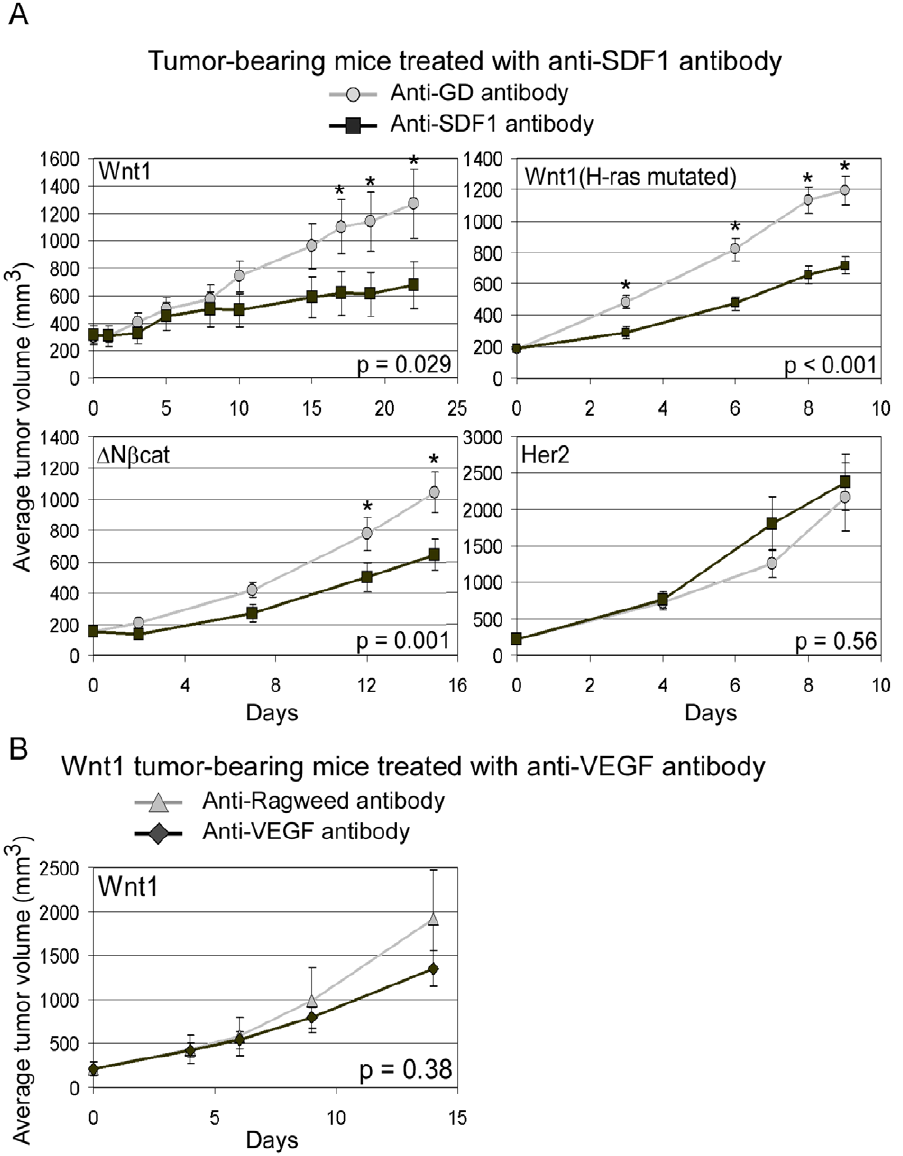
Figure 4. MMTV tumor-bearing mice treated with anti-SDF1 and anti-VEGF antibodies. Dissociated MMTV tumor cells were injected into nude mice, and tumor-bearing mice were injected with anti-SDF1 (circle) or control anti-GD (square) antibodies (A) and injected with anti-VEGF (diamond) or control anti-Ragweed antibodies (triangle; B). Average tumor volume was calculated from n=10 treated mice for anti-SDF1 treatments and n=5 for anti-VEGF treatment. Error bars represent + / 2 SEM. * indicates average tumor volumes that are statistically different between anti-GD and anti-SDF1 treatment groups (p , 0.05).